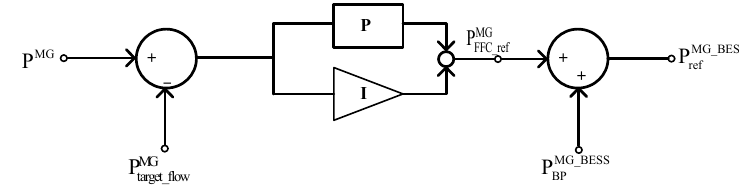
Figure 3. Control block of the BESS to manage flow of the MG PCC. P MG : measured value of the